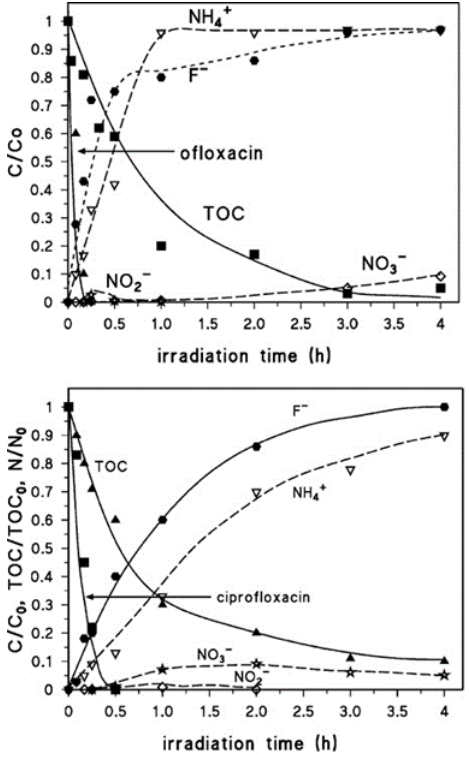
Figure 6. Degradation of ofloxacin (top) and ciprofloxacin (bottom) 15 mg L −1 on TiO 2 200 mg L −1 ; disappearance of initial compound, total organic carbon (TOC) and evolution of fluoride, ammonium, nitrite and nitrate ions. Reprinted with permission [64], copyright 2008, John Wiley and Sons. FQs